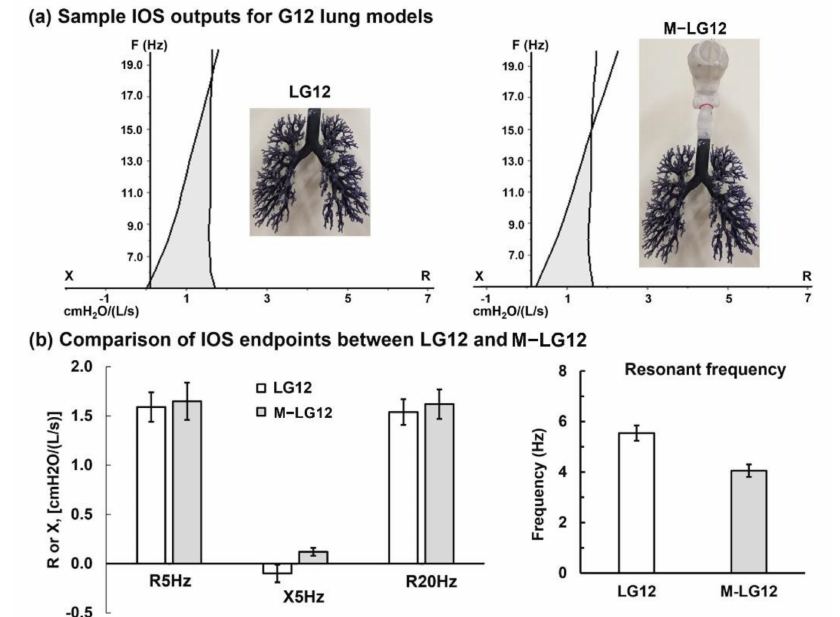
Figure 6. IOS characterization of the lung casts extending up to G12 (LG12); ( a ) sample IOS outputs for the lung cast model (LG12) and the mouth–lung model (M–LG12); ( b ) comparison of the ISO endpoints (R5Hz, X5Hz, R20Hz, and resonant frequency) between LG12 and M–LG12. The variables in ( a ) are the resistance R (cmH 2 O/(L/s)) in the positive x -axis, reactance X (cmH 2 O/(L/s)) in the negative x -axis, and frequency (Hz) in the y